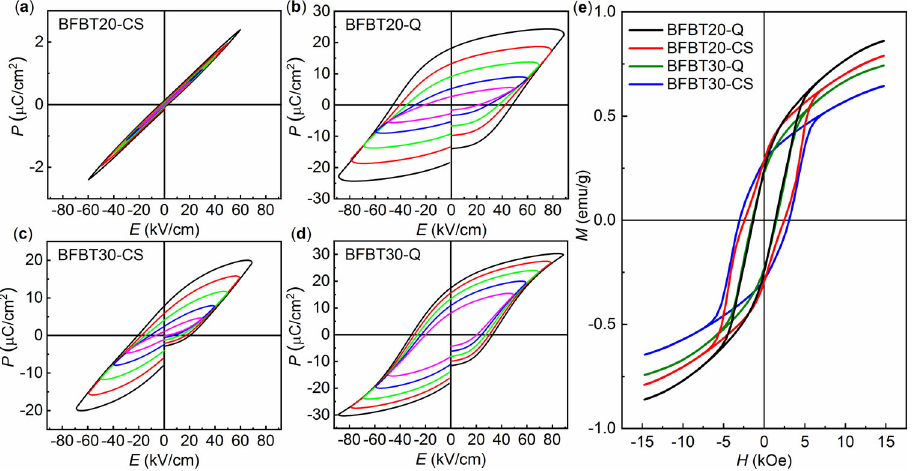
Fig. 3 (a–d) Ferroelectric hysteresis loops measured at10 Hz and (e) magnetic hysteresis loops measured at room